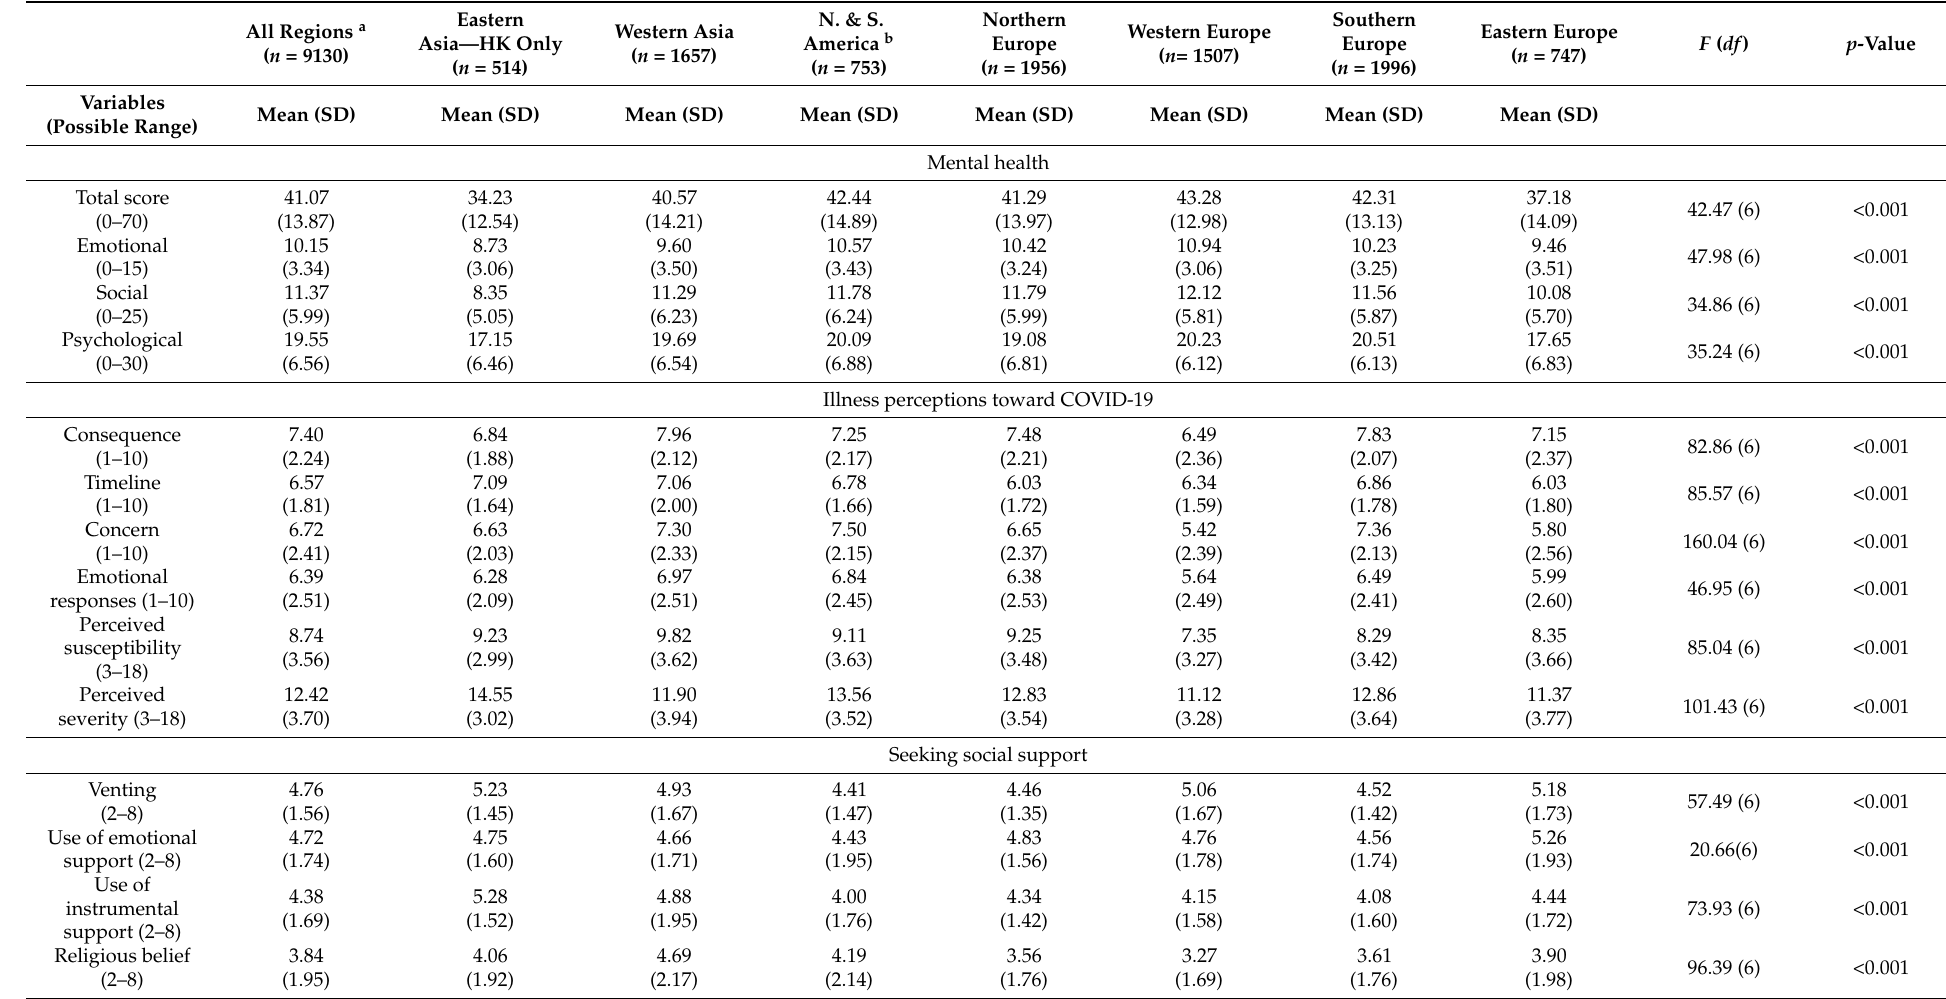
Table 2. Illness perceptions toward COVID-19, coping, prosociality, psychological flexibility and mental health of the participants per